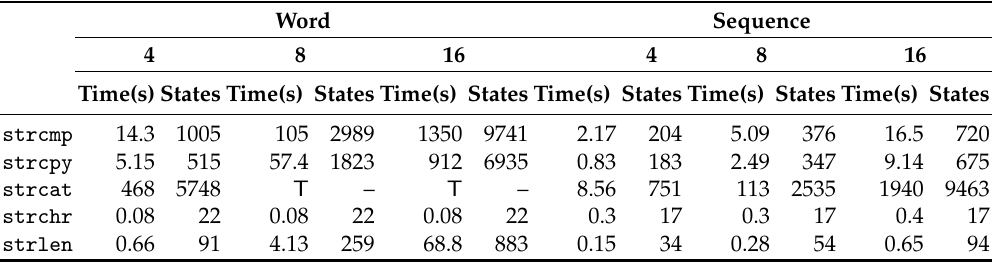
Table 4. Verification results of functions from PDCLib with timeout of 1 h. Measurements show the size of state space and verification time for the parametric length of the